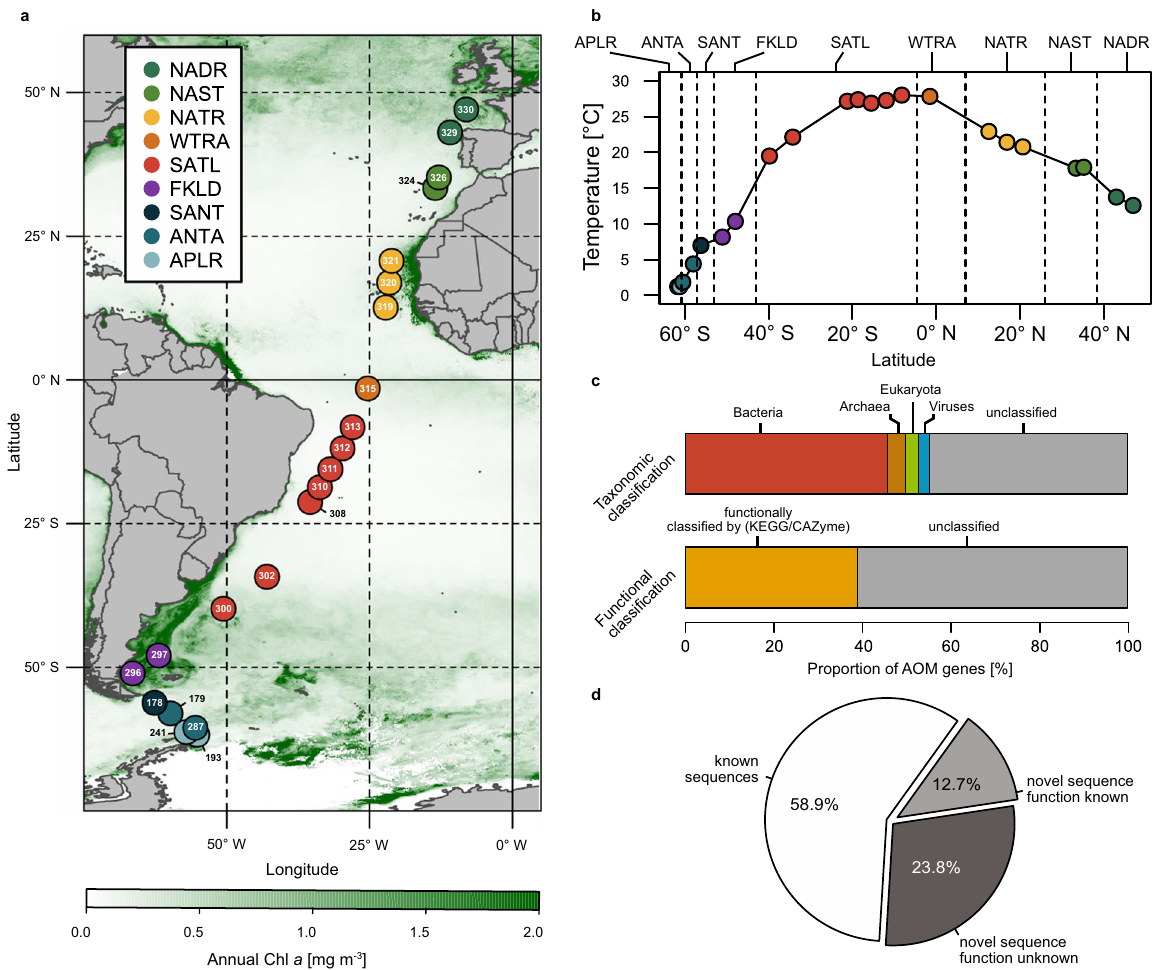
Fig. 1 Stations in the Atlantic and the Southern Ocean visited during cruises ANTXXVIII/4 and -/5 with RV Polarstern for assessing the Atlantic Ocean Microbiome (AOM) and basic AOM features. a Longhurstian provinces 22 of stations: Antarctic polar (APLR), Antarctic (ANTA), Subantarctic water ring (SANT), Southwest Atlantic Shelves (FKLD), South Atlantic gyre (SATL), Western tropical Atlantic (WTRA), North Atlantic gyre (NATR), North Atlantic subtropical (NAST), and North Atlantic drift (NADR). For further station details see Supplementary Table 1. Stations are overlayed on a map with annual mean concentrations of chlorophyll a at the surface (https://oceandata.sci.gsfc.nasa.gov). b Water temperature at 20 m sampling depth. c Percentages of taxonomic (Bacteria, Viruses, Archaea, Eukaryota, and unclassi fi ed) and functional (KEGG, CAZymes, and unclassi fi ed) annotations of 7.75 Million nr-gene sequences of the AOM. d Comparison of AOM gene novelty to the reference gene catalog of the Tara-Ocean data set